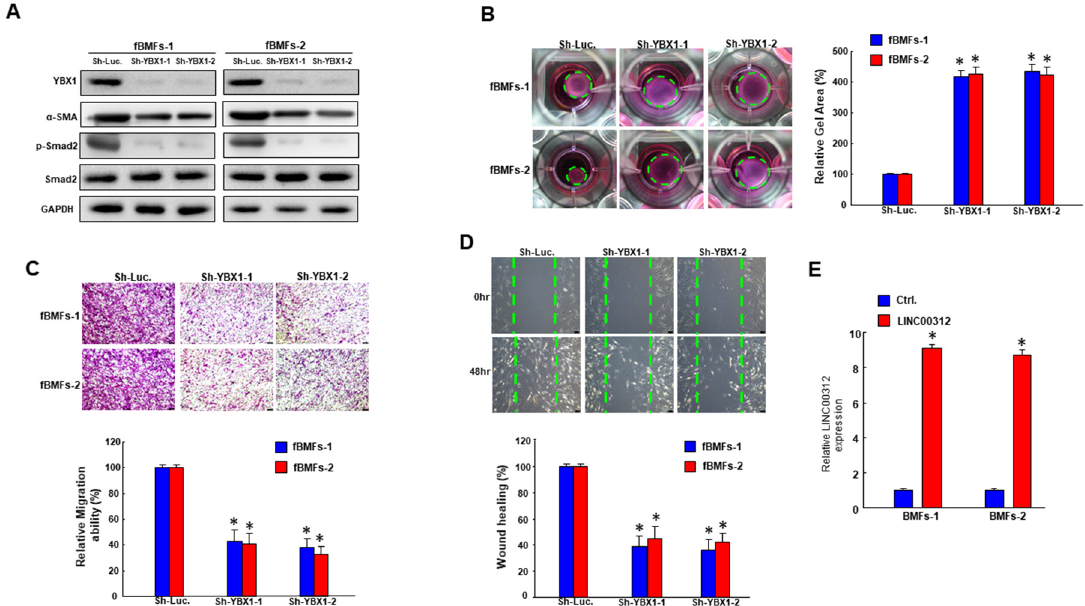
Figure 4. Downregulation of YBX1 in fBMFs diminishes the expression of fibrosis-associated markers and the myofibroblast activities. ( A ) Knockdown efficiency of YBX1 and the inhibited expression of fibrosis-associated markers ( α -SMA and p-Smad2) were confirmed by Western blot following the silencing of YBX1. Downregulation of YBX1 in fBMFs repressed the myofibroblast activities, including collagen gen contractility ( B ), migration ( C ), and wound healing ( D ) capacities. Results are means ± SD of triplicate samples from three experiments. ( E ) The overexpression effect of LINC00312 in BMFs was validated by qRT-PCR analysis. * p < 0.05 compared to the Sh-Luc group.